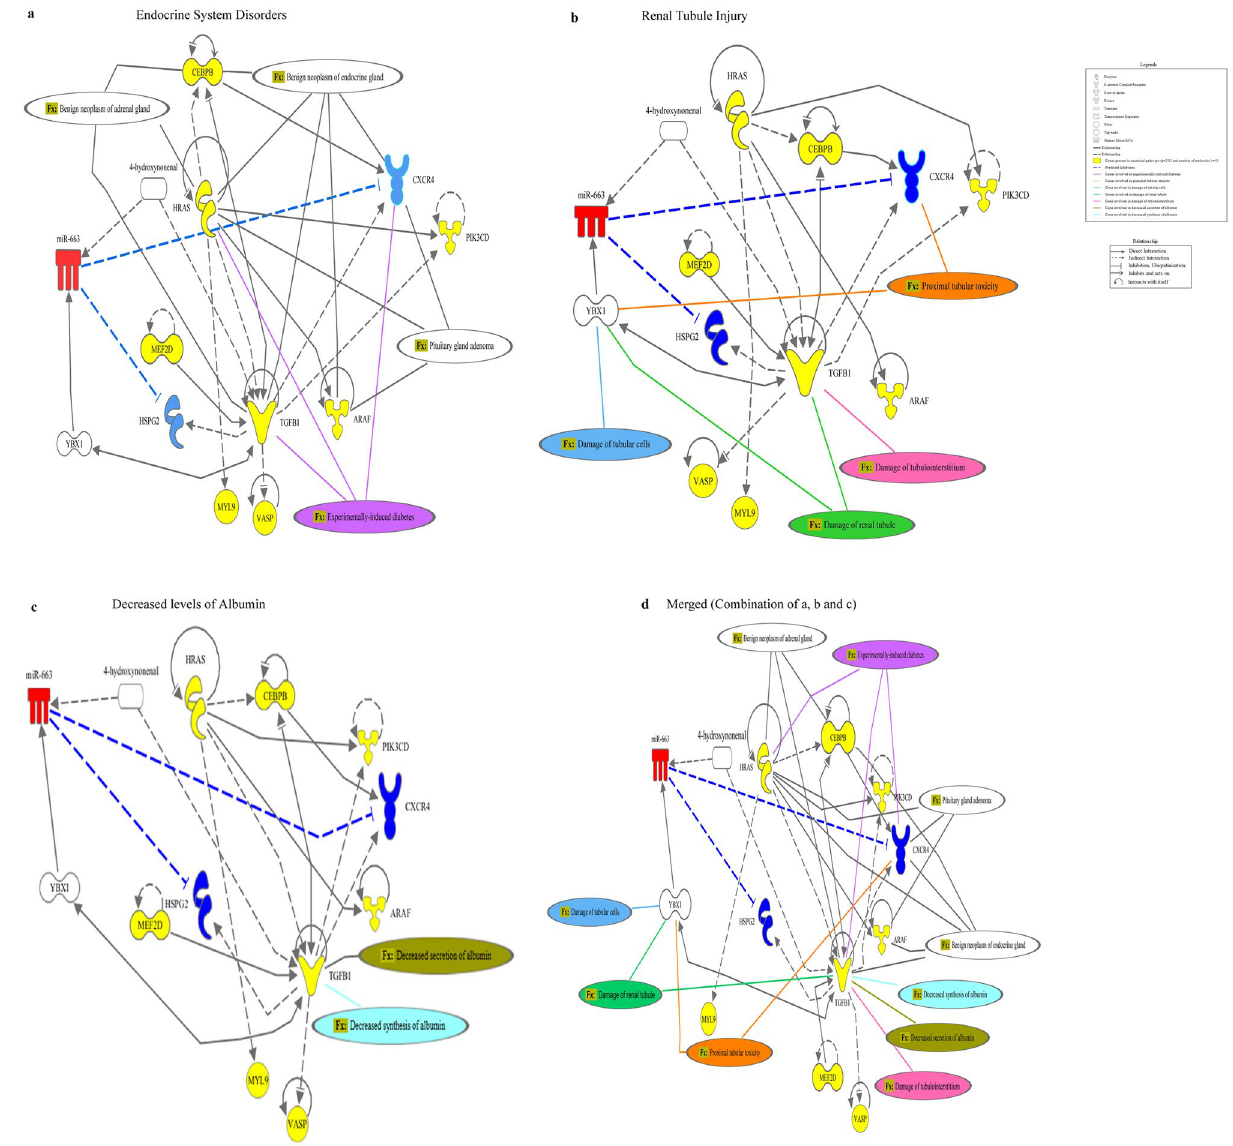
Figure 5. Disease and function analysis of the network by Ingenuity Pathway Analysis. The topological network created by Ingenuity Pathway Analysis Software when overlaid by the ‘Disease and Function’ tool generated ( a ) Endocrine System Disorders ( p = 1.53E−07–3.89E−5). Genes involved in experimentally induced diabetes were—CXCR4, HRAS, and TGF-β1 (purple line). ( b ) Renal Tubule Injury ( p = 5.76E−04–9.09E−03). This included sub-categories which were—Damage to tubule cells which consisted of gene YBX1 (sky blue line); Damage to renal tubules which involved genes YBX1 and TGF-β1 (green line); Damage of tubulointerstitium indicated TGF-β1 gene (pink line) and proximal tubular toxicity pointed CXCR4 and YBX1 gene (orange line). ( c ) Decreased levels of albumin ( p = 2.28E−03–3.04E−3) included decreased synthesis (cyan line) and decreased secretion of albumin (light green line) with TGF-β1 as the central gene for both. ‘Molecule Activity Predictor’ predicted the relationship between miR-663 and CXCR4 (Reference no. 47) as well as miR-663 and HSPG2 (Reference no. 48) to be inhibited when the miR-663 expression was elevated based on the research findings of Ingenuity Knowledge Database. ( d ) Complete network showing Endocrine System Disorders, Renal Tubule Injury, and Decreased levels of albumin altogether. All molecules are represented in different shapes which are the default icon in Ingenuity Pathway Analysis software and all details of color-coded lines are mentioned in the legend. miR, Micro Ribonucleic Acid; HRAS, Harvey Rat Sarcoma Viral Oncogene Homolog; CEBPB, CCAAT/ Enhancer-Binding Protein (C/EBP), beta; ARAF, A-RAF Proto-Oncogene, Serine/Threonine Kinase; PIK3CD, Phosphatidylinositol-4,5-bisphosphate 3-kinase, catalytic subunit delta; CXCR4, C-X-C Chemokine Receptor 4; TGF-β1, Transforming Growth Factor-Beta 1; MEF2D, Myocyte Enhancer Factor 2D; VASP, Vasodilator- Stimulated Phosphoprotein; MYL9, Myosin, Light Chain 9, regulatory; HSPG2, Heparan Sulfate Proteoglycan 2; YBX1, Y-Box Binding Protein